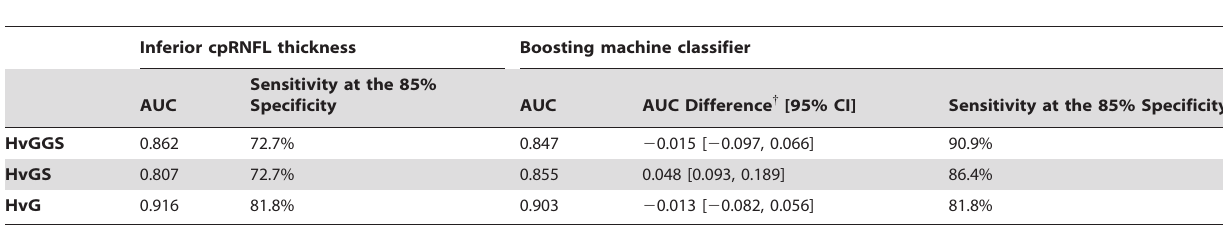
Table 5. Area under the receiver operating characteristic curves (AUCs) computed with machine classifier and Cirrus HD-OCT software generated cpRNFL thickness in inferior